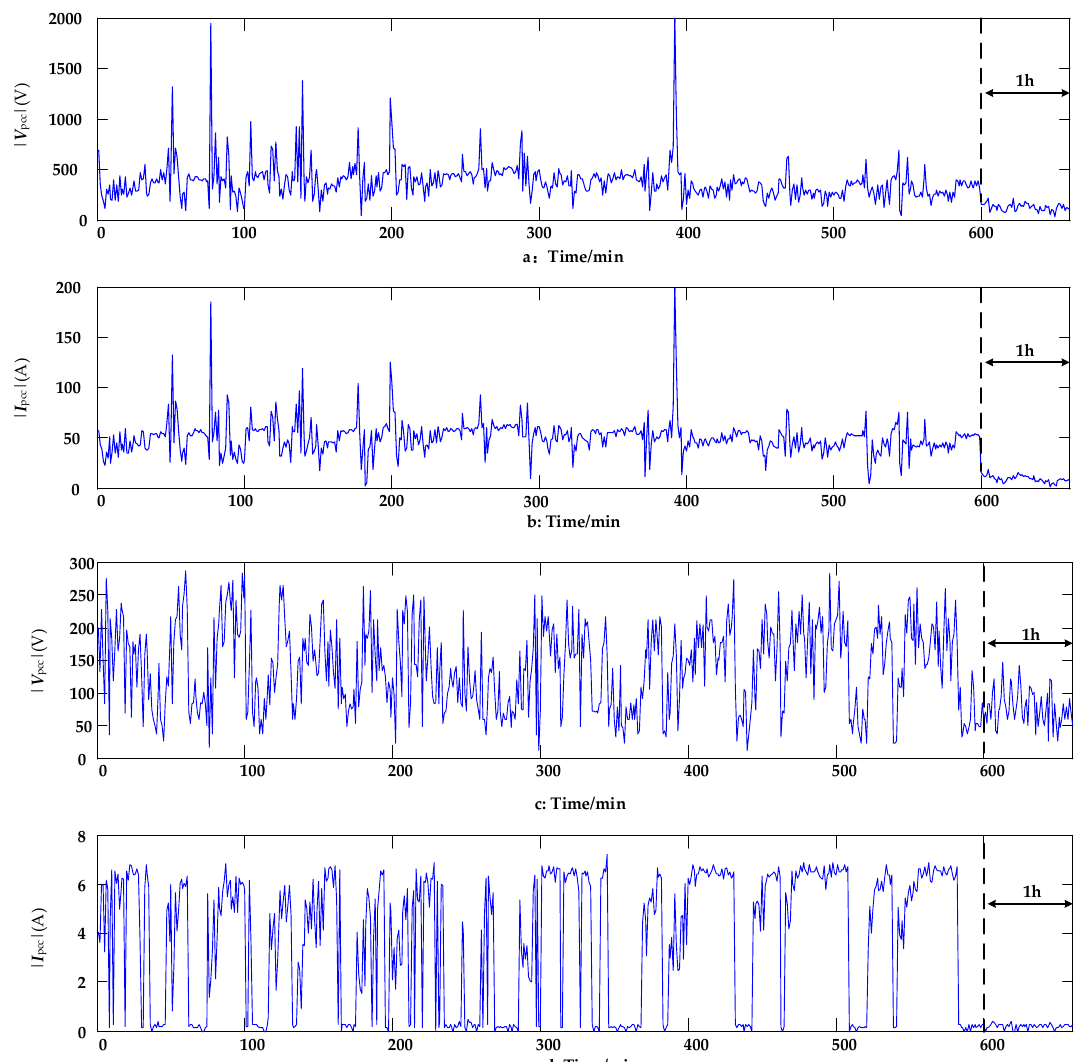
Figure 8. Waveforms harmonic current and voltage amplitude at PCC : ( a ) Magnitude of 3rd harmonic voltage; ( b ) magnitude of 3rd harmonic current; ( c ) magnitude of 11th harmonic voltage; ( d ) magnitude of 11th harmonic current.